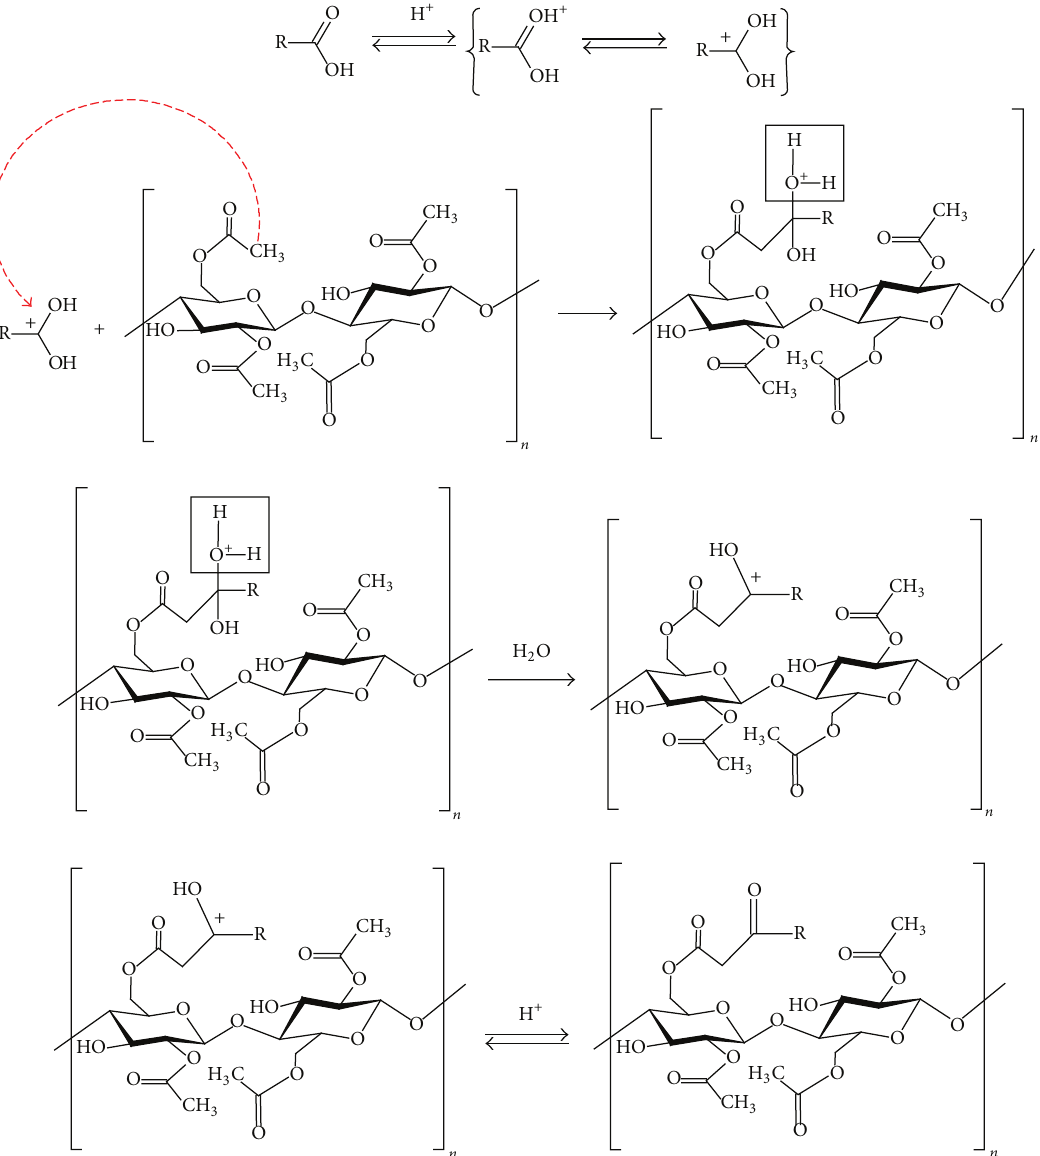
Figure 8: Mechanism based on reaction between carboxylic groups and acetyl groups